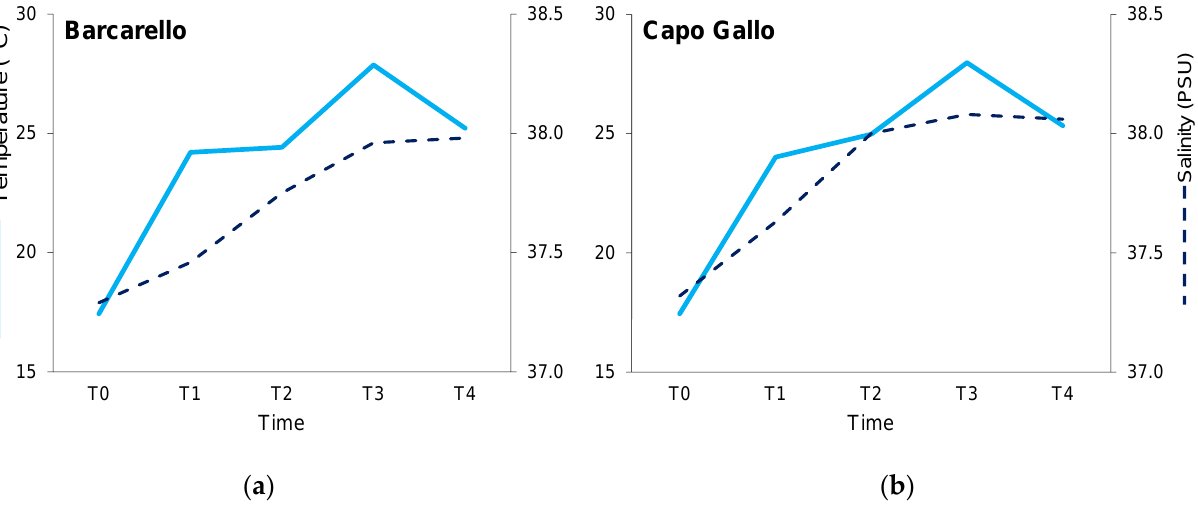
Figure 2. Surface water temperature (°C) and salinity (PSU) measured at the two sites across time: ( a ) Barcarello, ( b ) Capo Gallo.